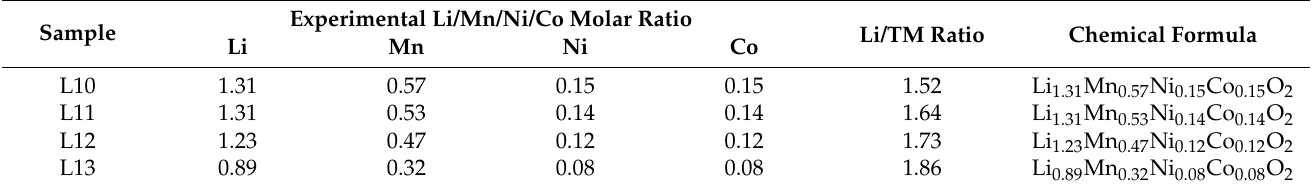
Table 1. Chemical composition of samples L10–L13 prepared by various Li/TM ratios. Experimental Li/Mn/Ni/Co Molar Ratio Sample